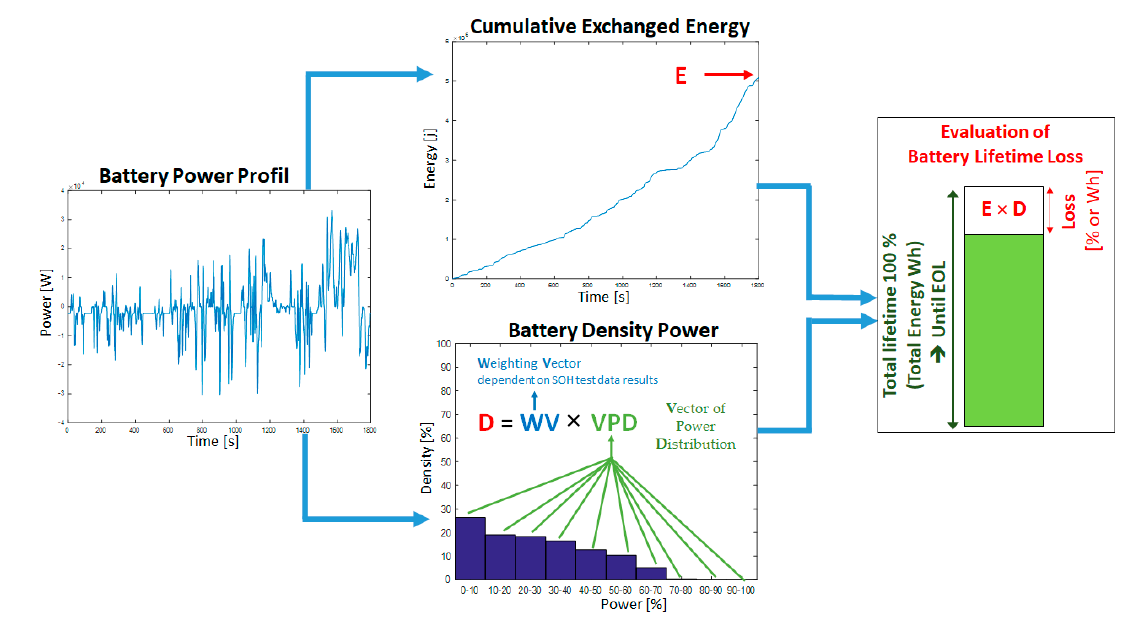
Figure 5. Battery reliability assessment module [28].